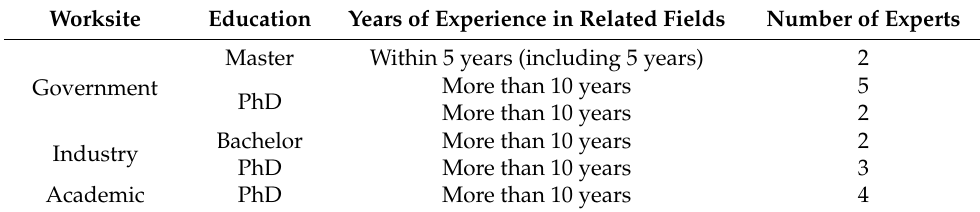
Table 2. Backgrounds of experts.